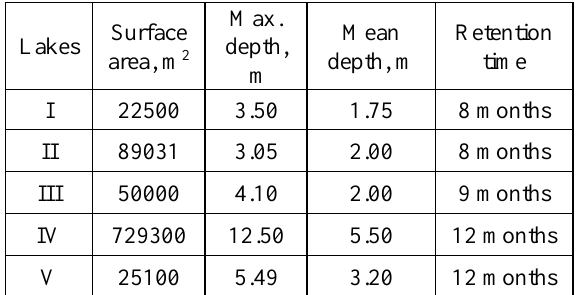
Table 1. Morphometric data of